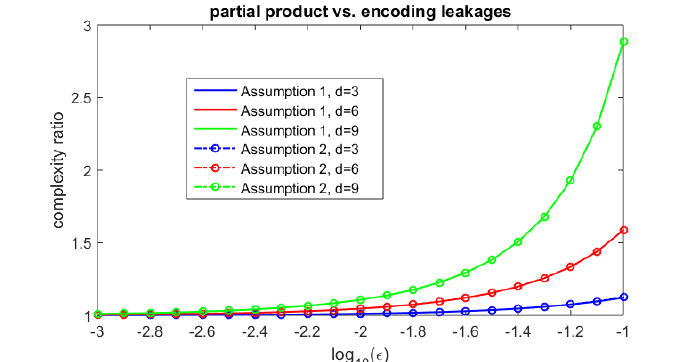
Figure 14: Information gain of masked